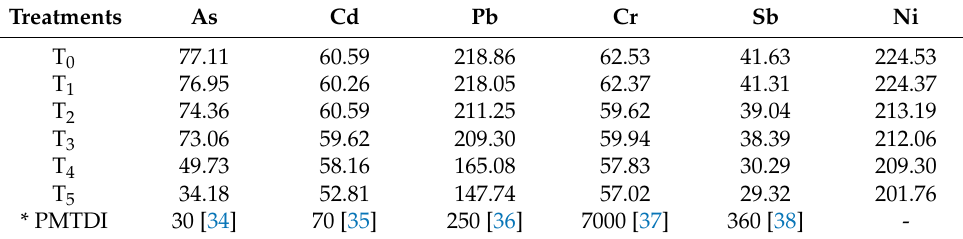
Table 3. Estimated daily intake of heavy metals through rice consumption in relation to PMTDI.